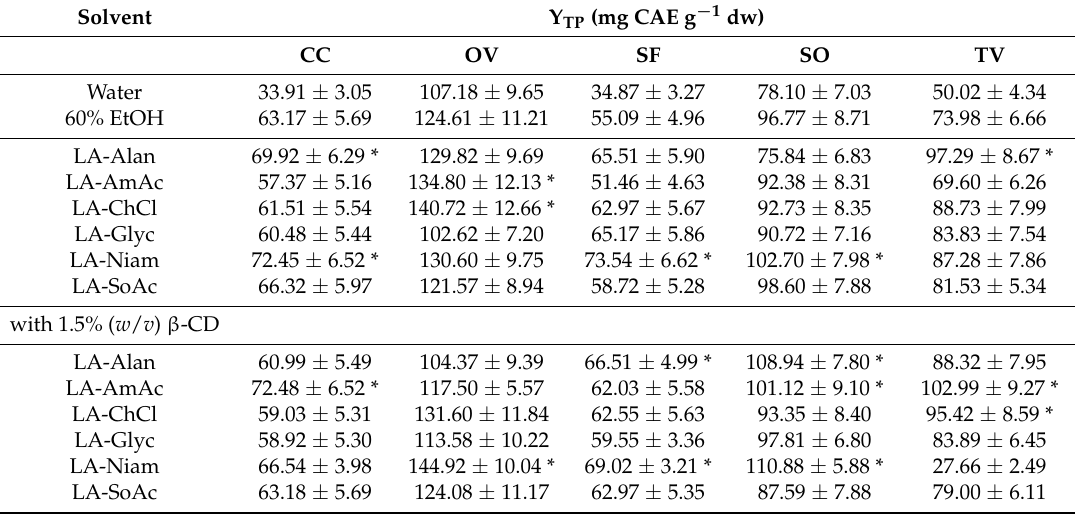
Table 3. Y TP (mg CAE g − 1 dw) of the extracts obtained using DES and β -CD/DES combination. Asterisk denotes statistically higher value ( p <